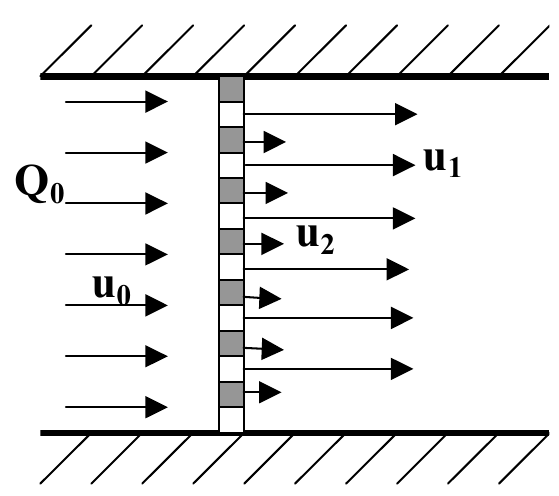
Figure 1. Flow motion through a screen of a woven structure.